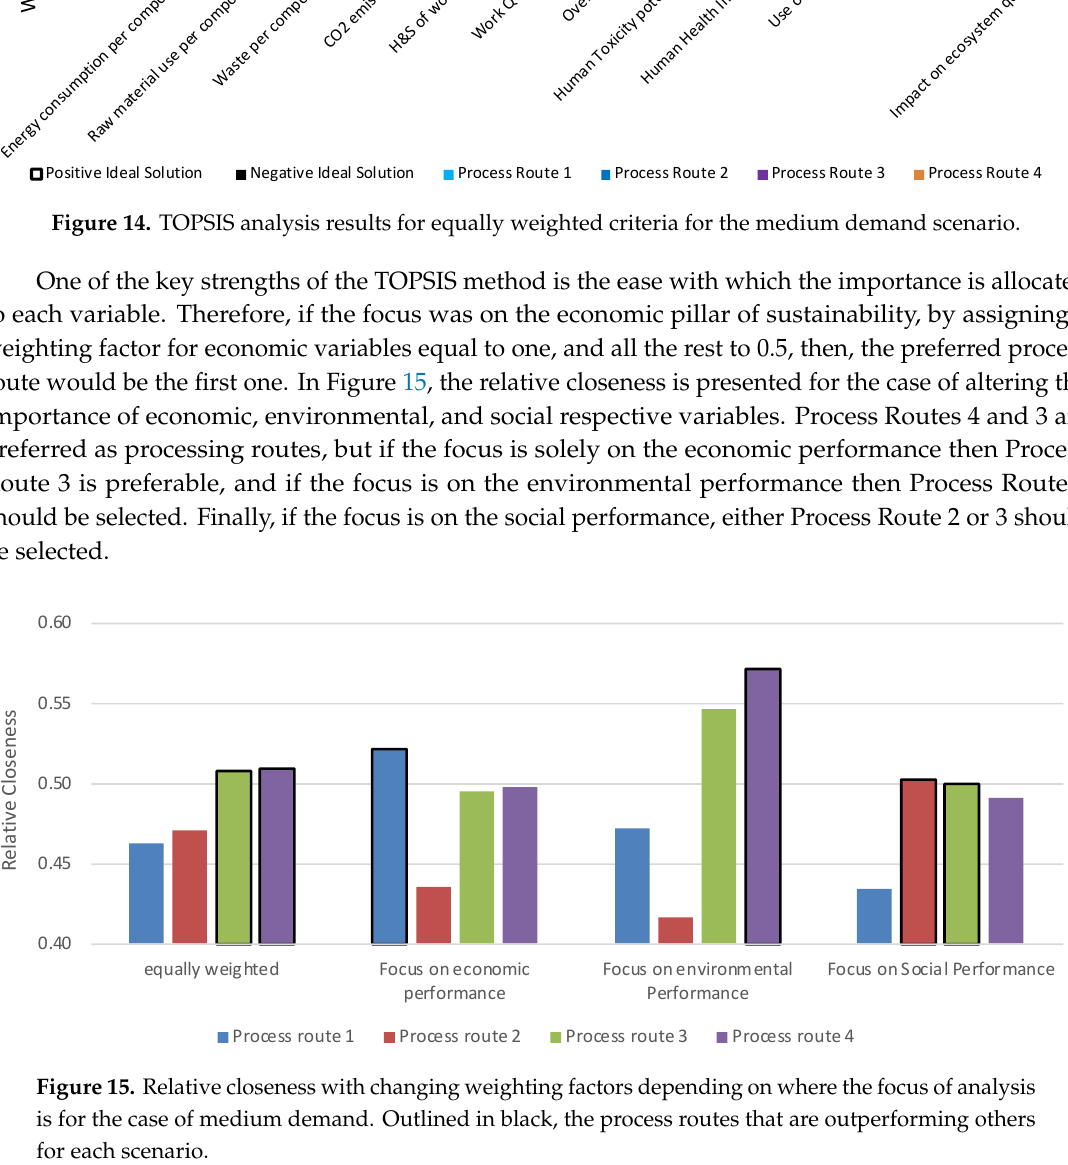
Figure 14. TOPSIS analysis results for equally weighted criteria for the medium demand scenario.